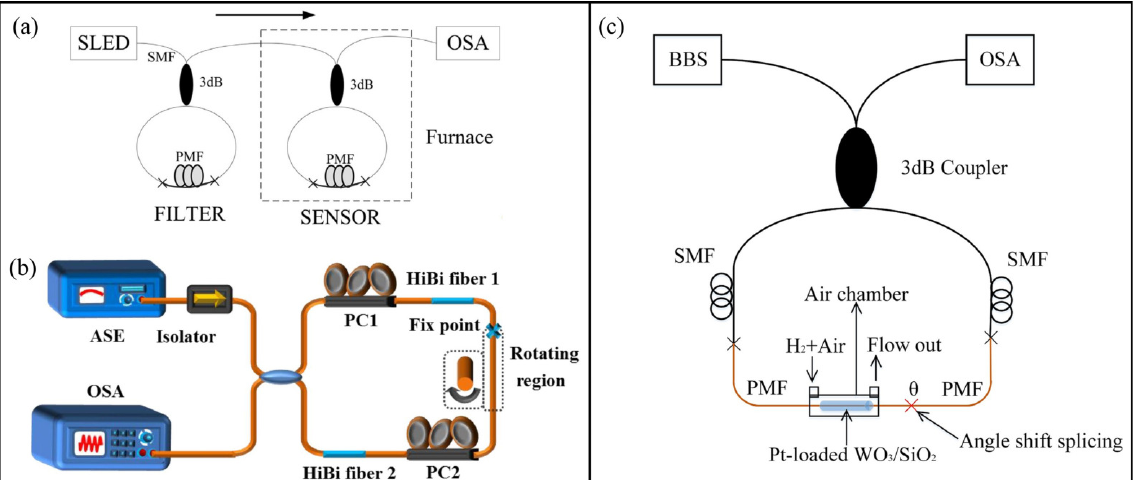
Figure 8. Vernier effect fiber sensor formed by ( a ) cascading two FLMs [58], ( b ) inserting two Hi- Bi fiber segments into a fiber loop [62], ( c ) angle shift-splicing two Hi-Bi fibers in a single Sagnac loop [63]. Reprinted with permission from Refs. [58,63]